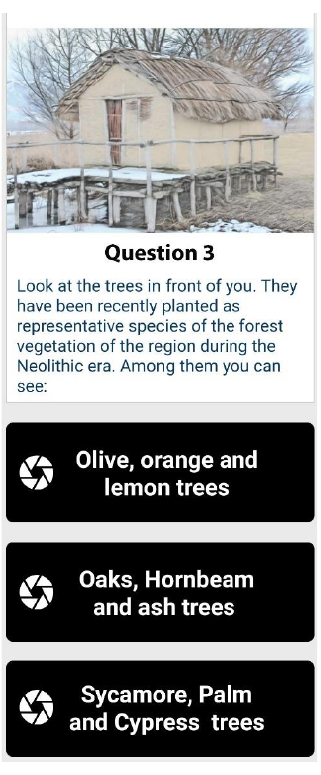
Figure 7. Question regarding the trees that could be found around the settlement in the Neolithic era.